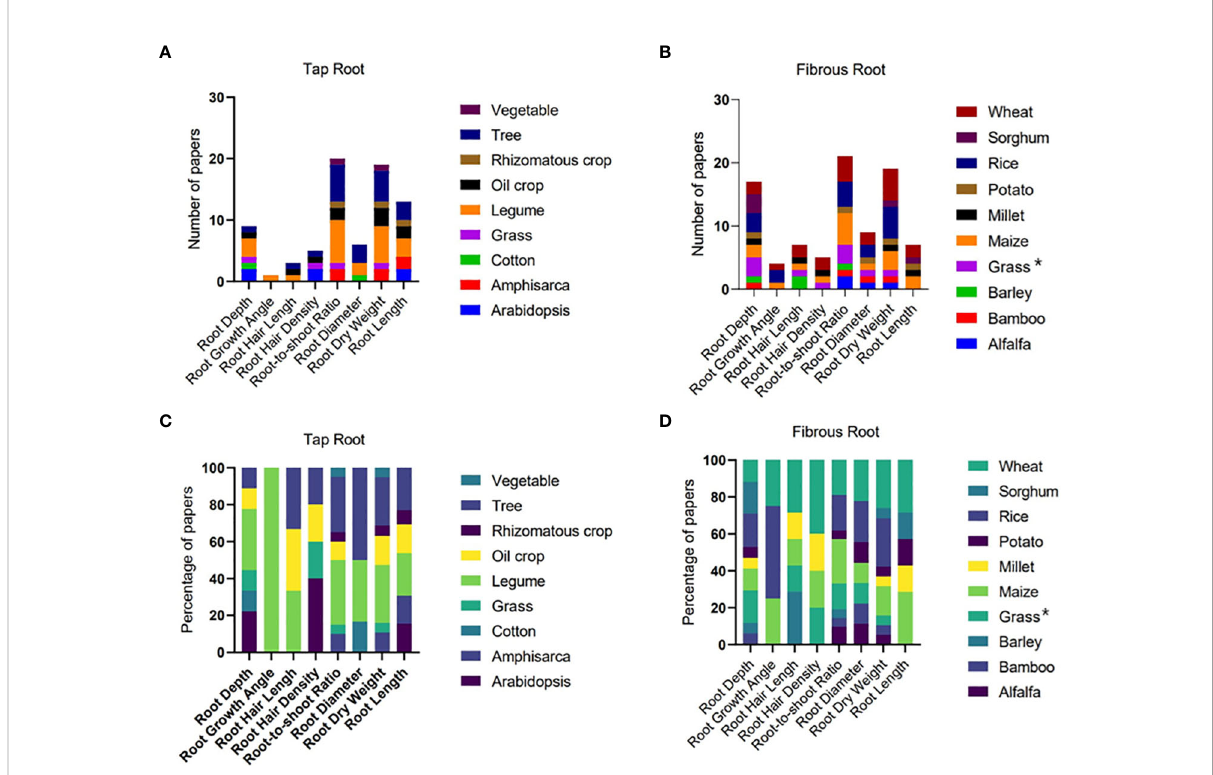
FIGURE 2 The number and percentage of papers reporting different root traits of different plant species with tap (A, C) and fi brous (B, D) root systems. Grasses in the tap root system include weed from Maganti et al (2005) and Paspalum dilatatum from Vasellati et al. (2001). Grasses in the fi brous root system (indicated by * in (B, D) include Perennial grass Dactylis glomerata from Bristiel et al. (2019), switchgrass from Liu et al. (2019), and perennial native grasses from Vega et al.